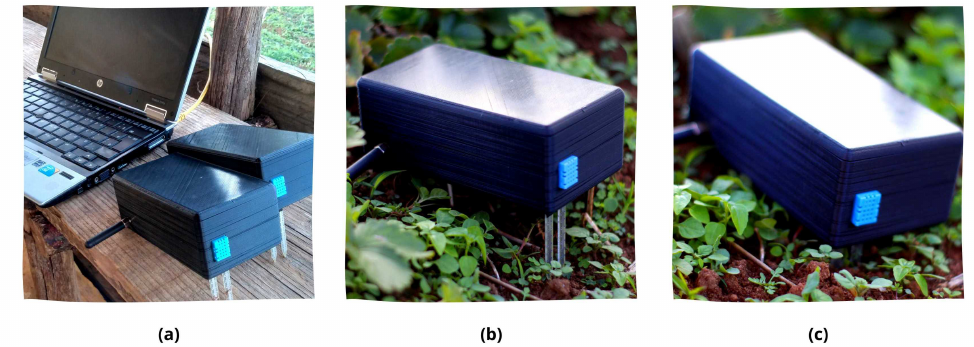
Figure 16. ( a ) Two sensor nodes and the computer used to present the dashboard, ( b ) sensor node positioned, and ( c ) sensor node deployed on the